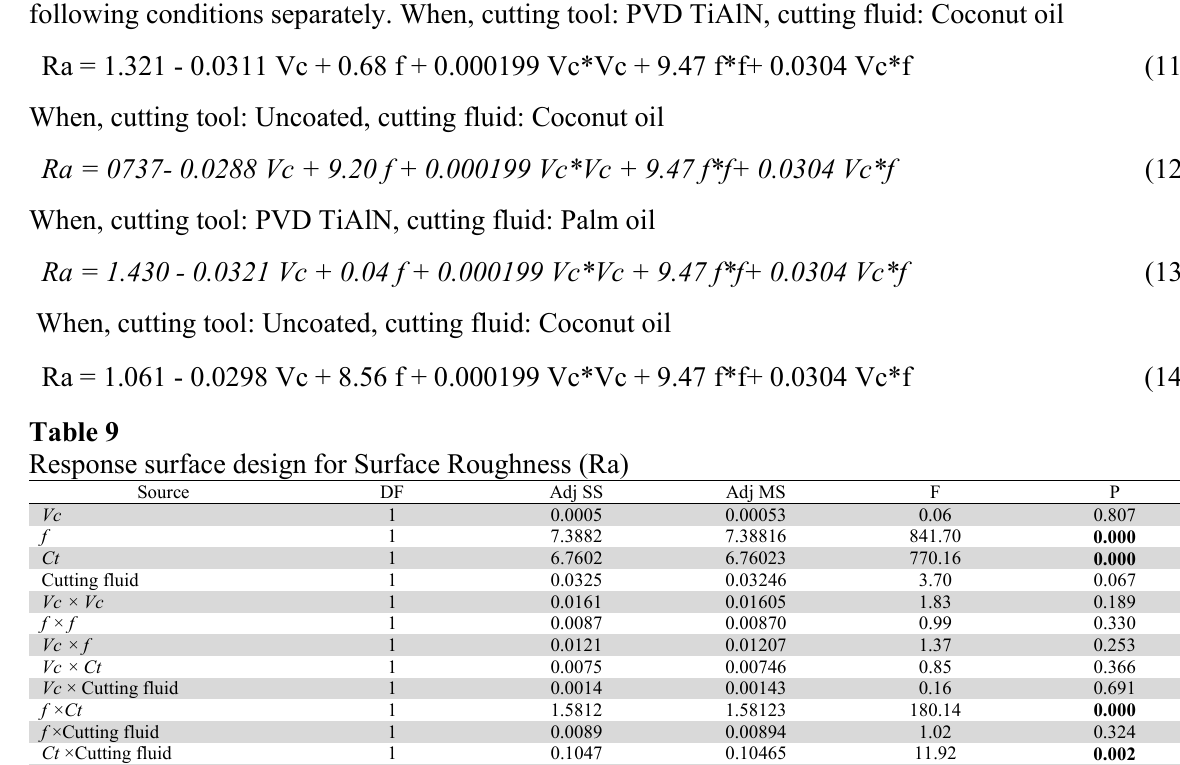
Table 9 gives the response surface regression of surface roughness. The value ‘p’ i.e. probability of obtaining a result equal to or more extreme than what was actually observed. If ‘p’ value for the model is less than 0.05 which shows that the model terms are important. In order to understand the turning process, the experimental results were used to develop the second order model using response surface methodology (RSM). MINITAB 17 was used for the statistical analysis of experimental results. The proposed quadratic model was developed from the functional relationship using RSM method for following conditions separately. When, cutting tool: PVD TiAlN, cutting fluid: Coconut oil